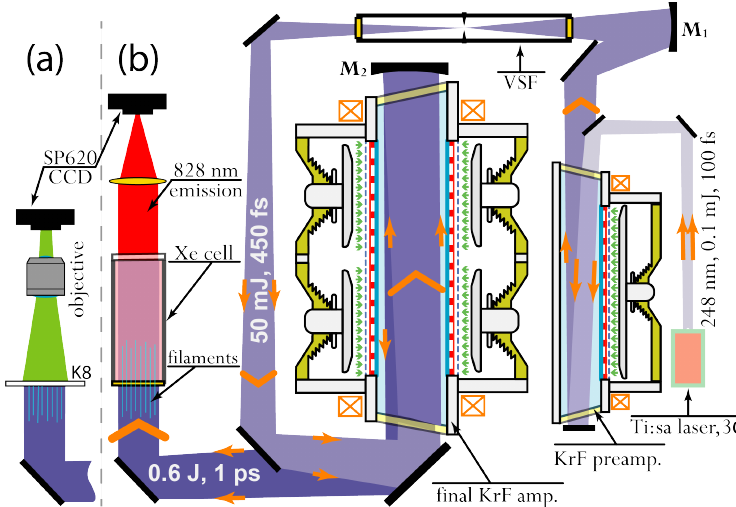
Figure 1. Layout of the experimental setup and scheme for visualization of ( a ) UV laser beam and ( b ) IR conical emission.